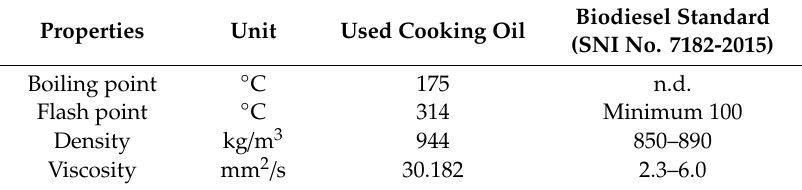
Table 1. The physicochemical properties of used cooking oil and biodiesel standards.